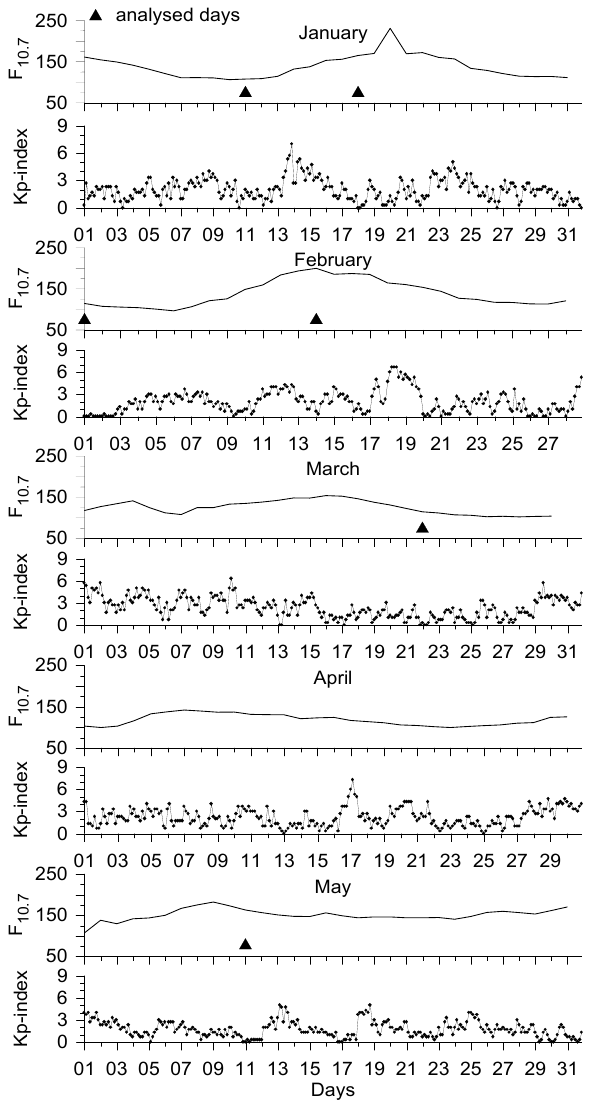
Fig. 2. Variations of the solar and geomagnetic activity during January–May